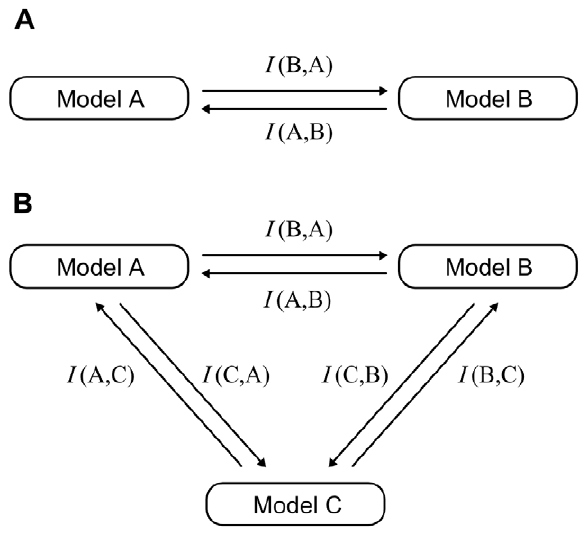
Figure 1. Discrimination of kinetic models by maximization of the extended Kullback-Leibler distance ( I ). Conditions are sought that maximize I in both directions between any two models. In a two candidate model scenario (A) two functions must be simultaneously optimized. In a three candidate model scenario (B) six functions must be simultaneously optimized. After optimization, the set of solutions approximate a Pareto front and represent a compromise between the various objectives in the sense that, for any solution, the value of any objective could only be increased if the value of another objective was simultaneously decreased.